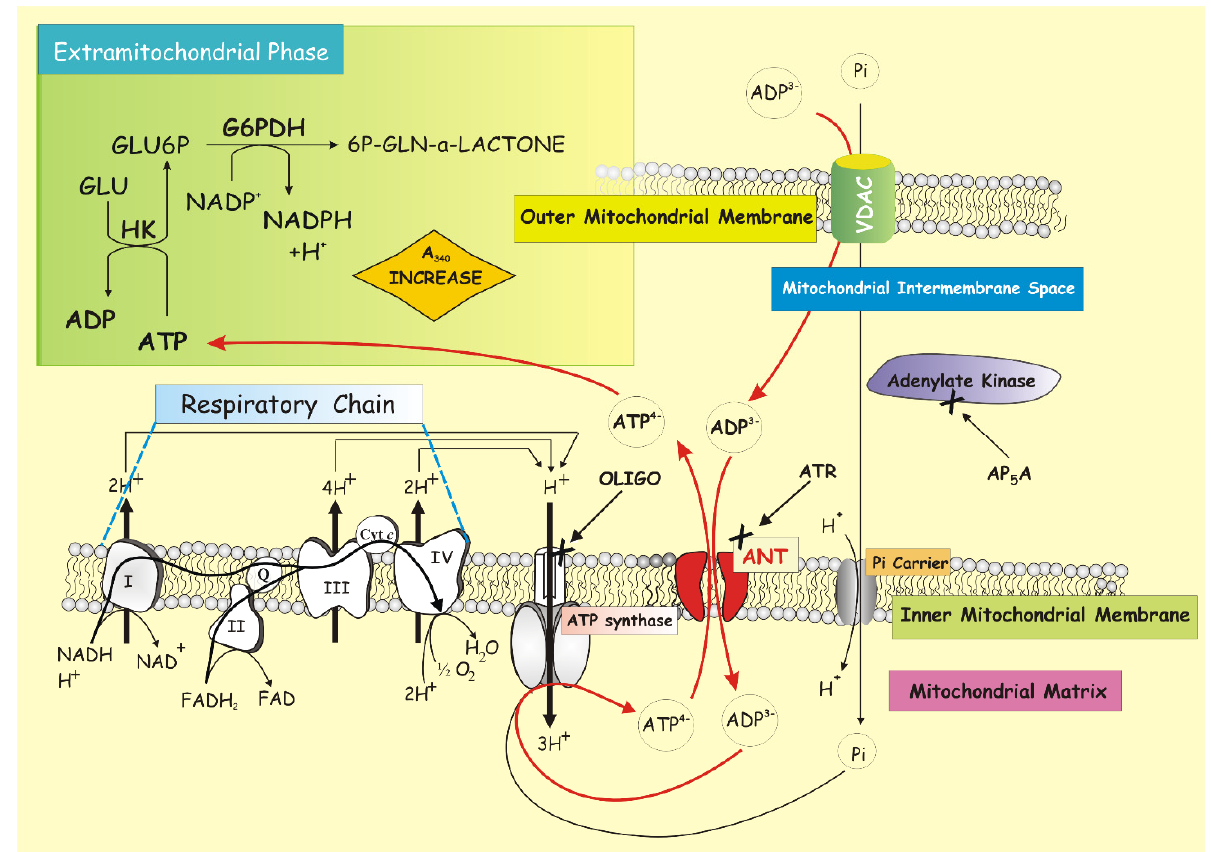
Figure 1. Functional activity of ANT-mediated ADP/ATP exchange revealed by an ATP detecting system. The ATP detecting system (ATP D.S.), depicted in the upper left panel, reveals the appearance of ATP in the extramitochondrial phase following the addition of ADP to the mitochondria and the synthesis of ATP via OXPHOS. As shown in the picture, since the activity of the ANT-dependent electrogenic ADP/ATP exchange strictly depends on the mitochondrial membrane potential, mitochondria must be actively “respiring and phosphorylating,” i.e., the activity of mRC that generates the electrochemical gradient transmembrane, and ATP synthesis must be closely coupled for the exchange to